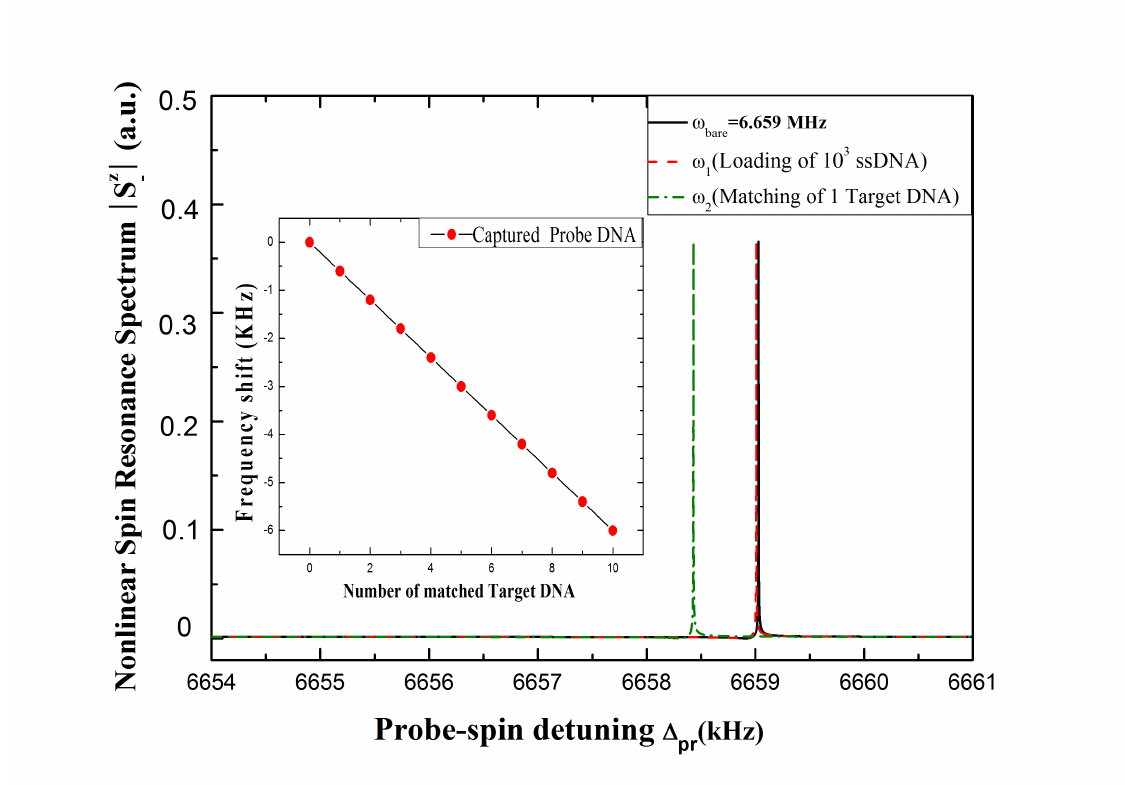
Figure 4. The nonlinear spin resonance spectrum with and without linking the ssDNA onto the surface of the hybrid spin-microcantilever. The black curve shows the initial resonance of the hybrid spin-microcantilever; the green-dashed curve indicates that after binding 10 3 capture ssDNA; and the red-dashed curve indicates that after binding one normal target DNA and one silica nanoparticle-enhanced probe DNA are linked to the capture ssDNA. The left inset exhibits the relationship between the frequency shift of the hybrid spin-microcantilever and the numbers of linked silica nanoparticle-enhanced probe DNAs. The other parameters used are the same as Figure